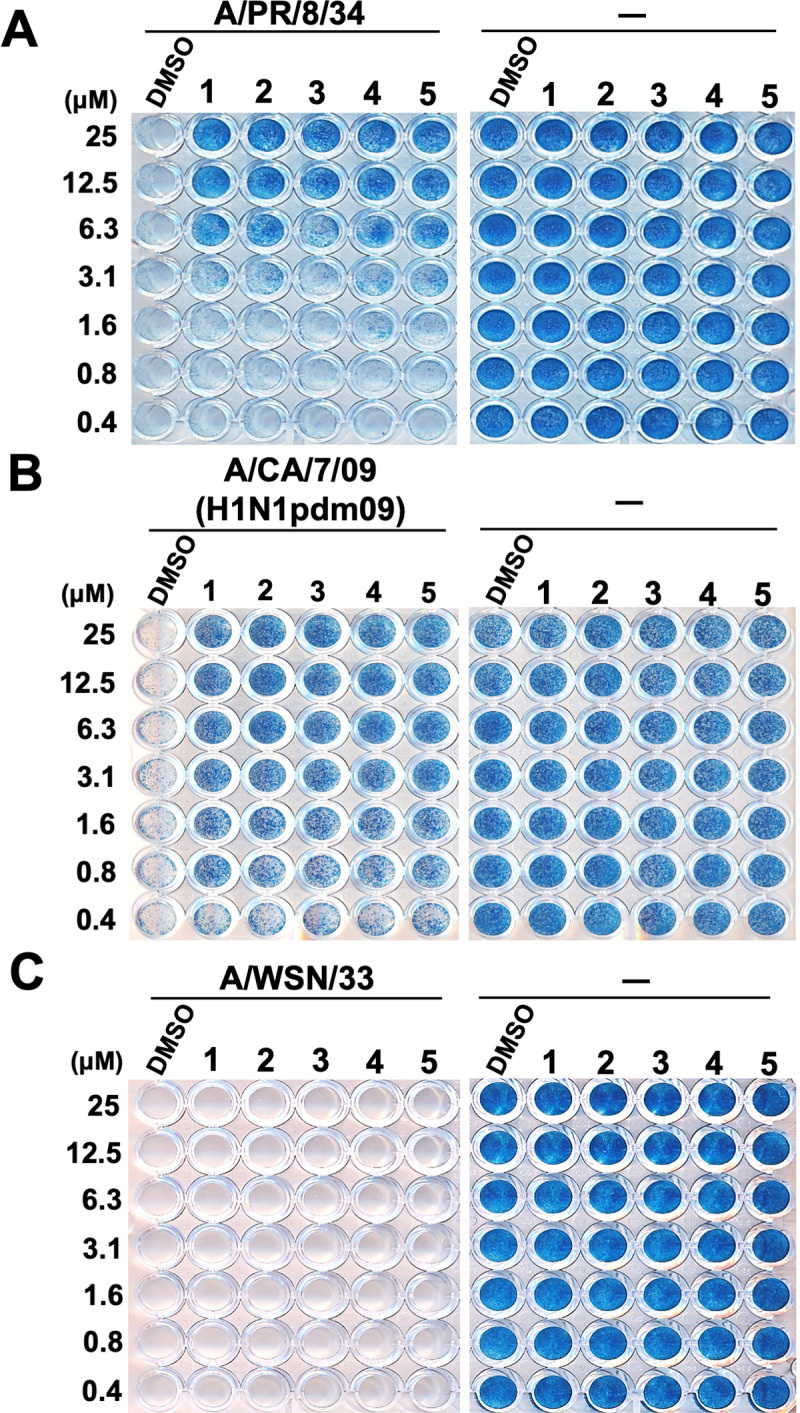
Cyclobakuchiols A–D promotes the viability of MDCK cells infected with influenza A viruses.Effects of cyclobakuchiols A (2), B (3), C (4), and D (5) on the viability of MDCK cells infected with influenza A viruses. 2–5 (0.4–25 μM) were mixed with or without the A/PR/8/34 (A), A/CA/7/09 (B), or A/WSN/33 (C) viruses and subsequently added to MDCK cells. DMSO (0.004–0.25%) and (+)-(S)-bakuchiol (1) (0.4–25 μM) were used as negative and positive controls, respectively. Cell viability was determined via naphthol blue-black staining after incubation for three days. Data are representative of three independent experiments. The results were reproducible across all experiments.